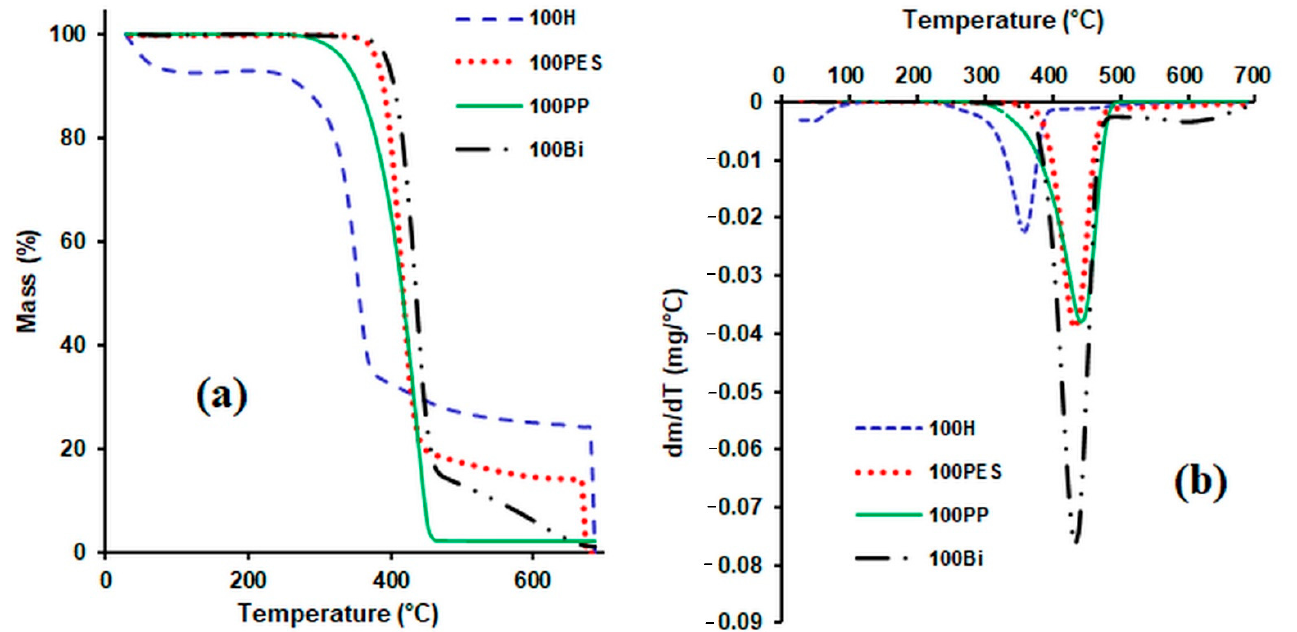
Figure 4. TG curves ( a ) and DTG curves ( b ) for hemp fibres and matrix polymer fibres.